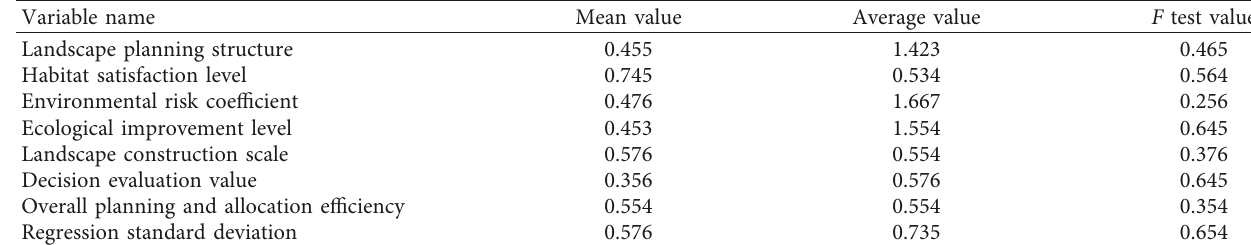
Table 1: Regression analysis value and test